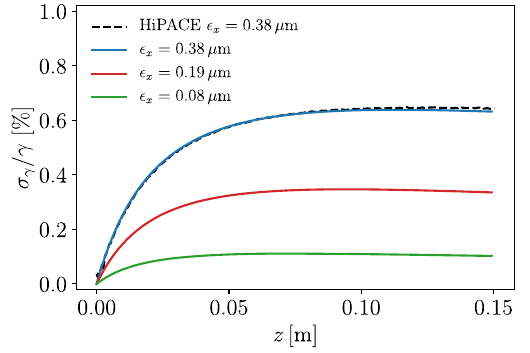
FIG. 5. Relative slice energy spread vs acceleration distance. Advancing test particles in an approximated step function yields similar energy-spread in comparison with the H i PACE simulation. The results indicate that emittances smaller than 0 . 1 μ m induce an energy spread below